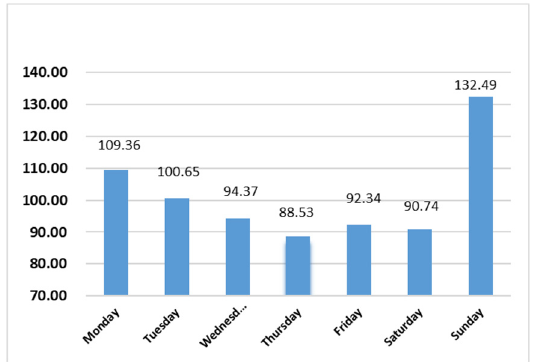
Figure 2. EPU across weekdays. The figure depicts the average of the Economic Uncertainty Policy (EPU) values across weekdays for 1985–2020. On Sundays and Mondays, the EPU is higher than on the rest of the weekdays. The difference between the EPU average on Mondays and Fridays is 17.02 (t-stat. = 7.92). The results are maintained when utilizing two equal subsamples: 1985–December 2002 and January 2003–February 2020.